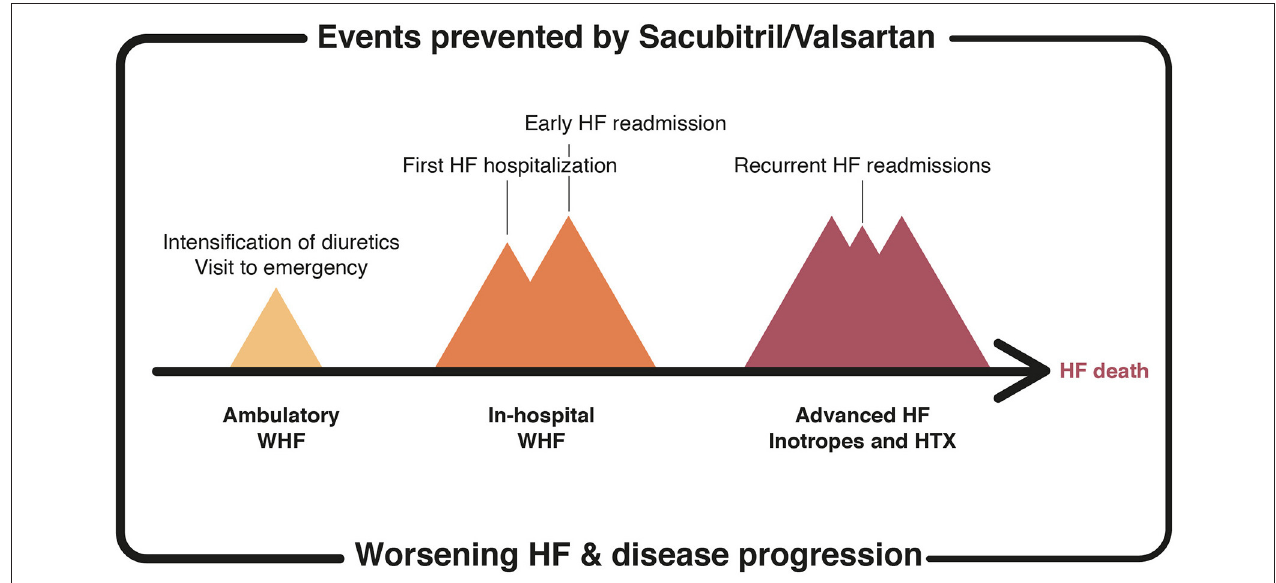
FIGURE 2 | HF-related events prevented by the treatment with sacubitril/valsartan. HF, heart failure; WHF, worsening HF; HTX, heart